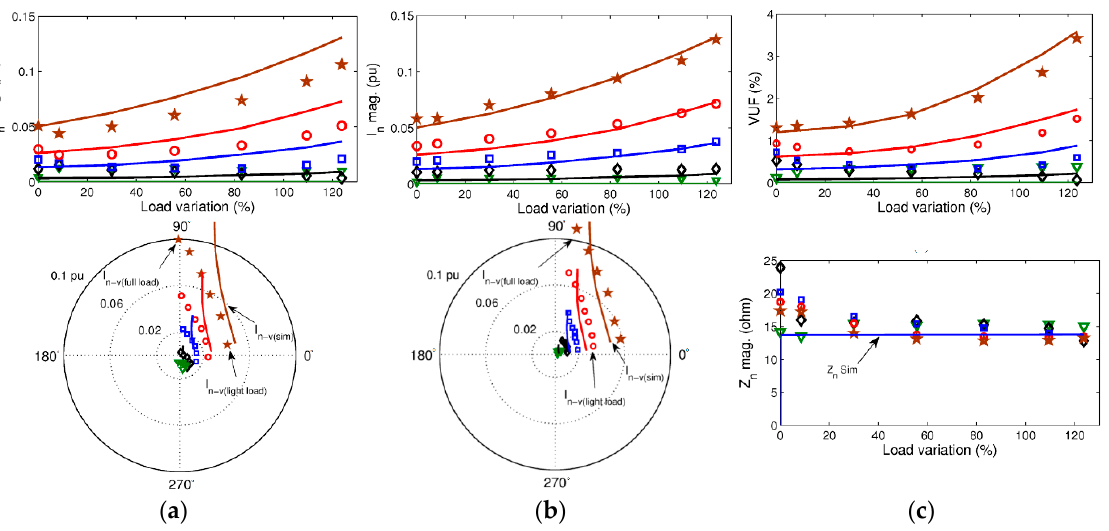
Figure 12. The experimental (symbols) and the simulated (solid lines) results of the current and voltage unbalance as a function of the load with a series resistor in one of the phases. The magnitude ( top ) and phasor trajectories ( bottom ) are also given before ( a ) and after ( b ) inherent asymmetry elimination, and the voltage unbalance factor ( top ) and negative sequence impedance ( bottom ) ( c ). The values of the external resistors were 0.25 Ω (triangle), 0.5 Ω (diamond), 1 Ω (square), 2 Ω (circle) and 4 Ω (star).